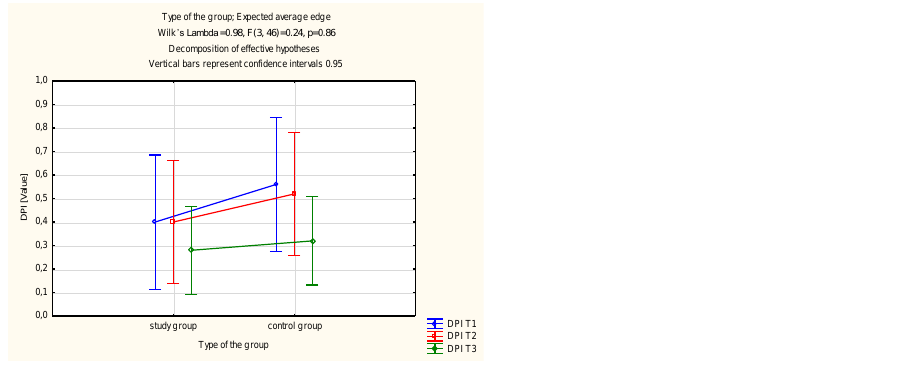
Figure 3. Estimated marginal means for the denture plaque index (DPI) in the study and control groups.